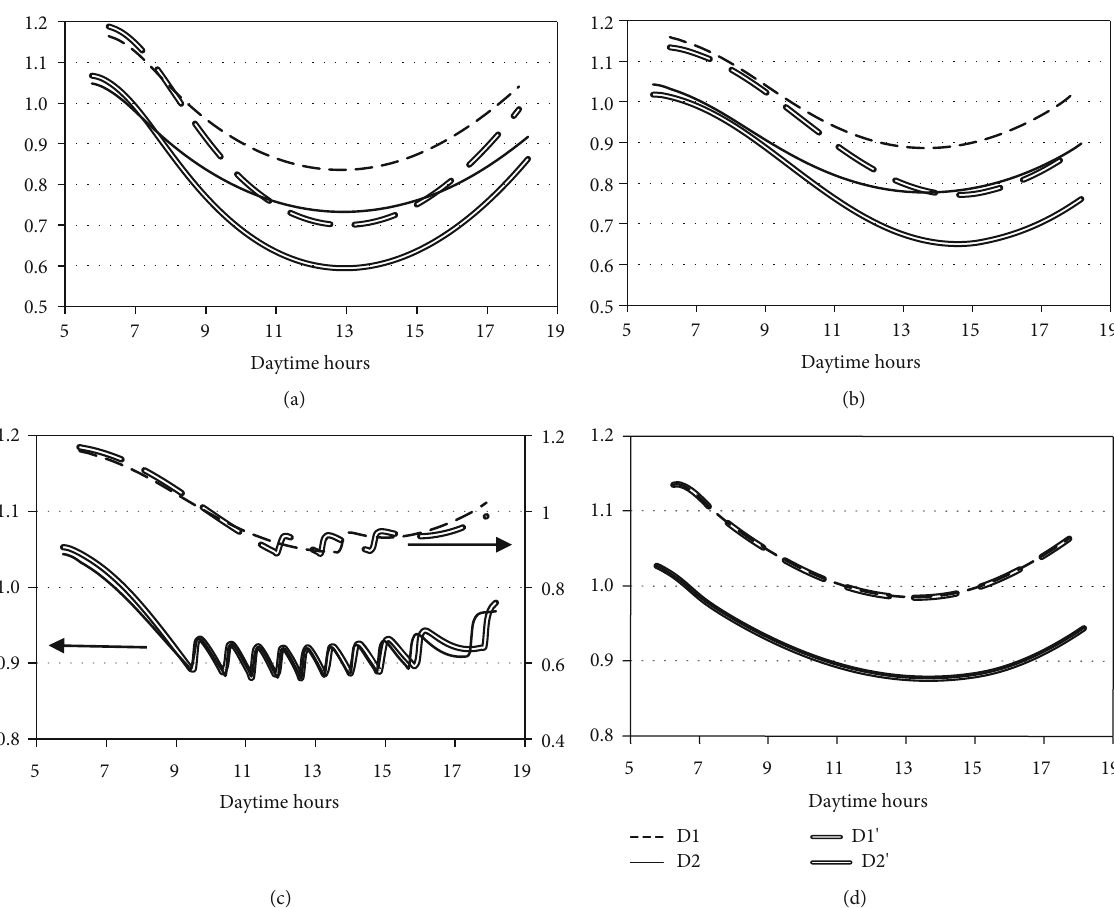
Figure 3: Daily dynamics of normalized photovoltaic e ffi ciencies: (a) PV panel, PV/T; (b) M1, (c) M2, (d) M3; ′ means that the device is